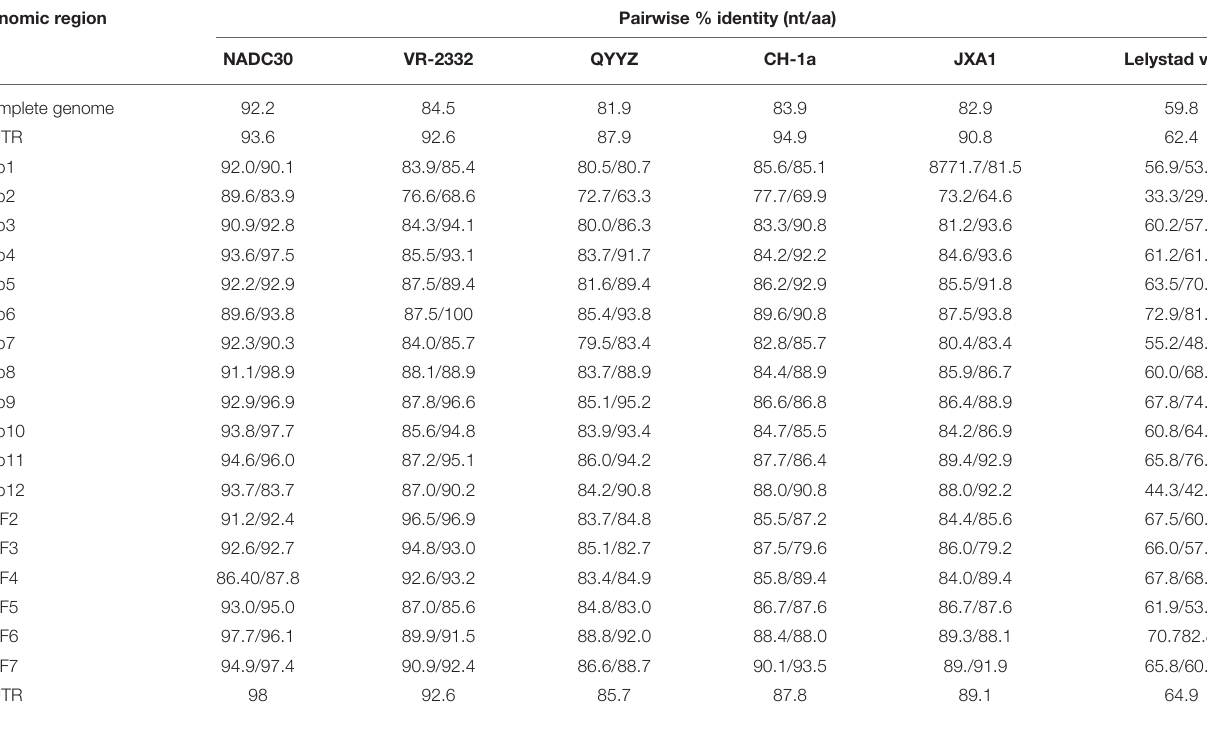
TABLE 3 | Nucleotide and amino acid identities of different regions of GXNN1839 compared with other type 2 PRRSV reference strains. Genomic